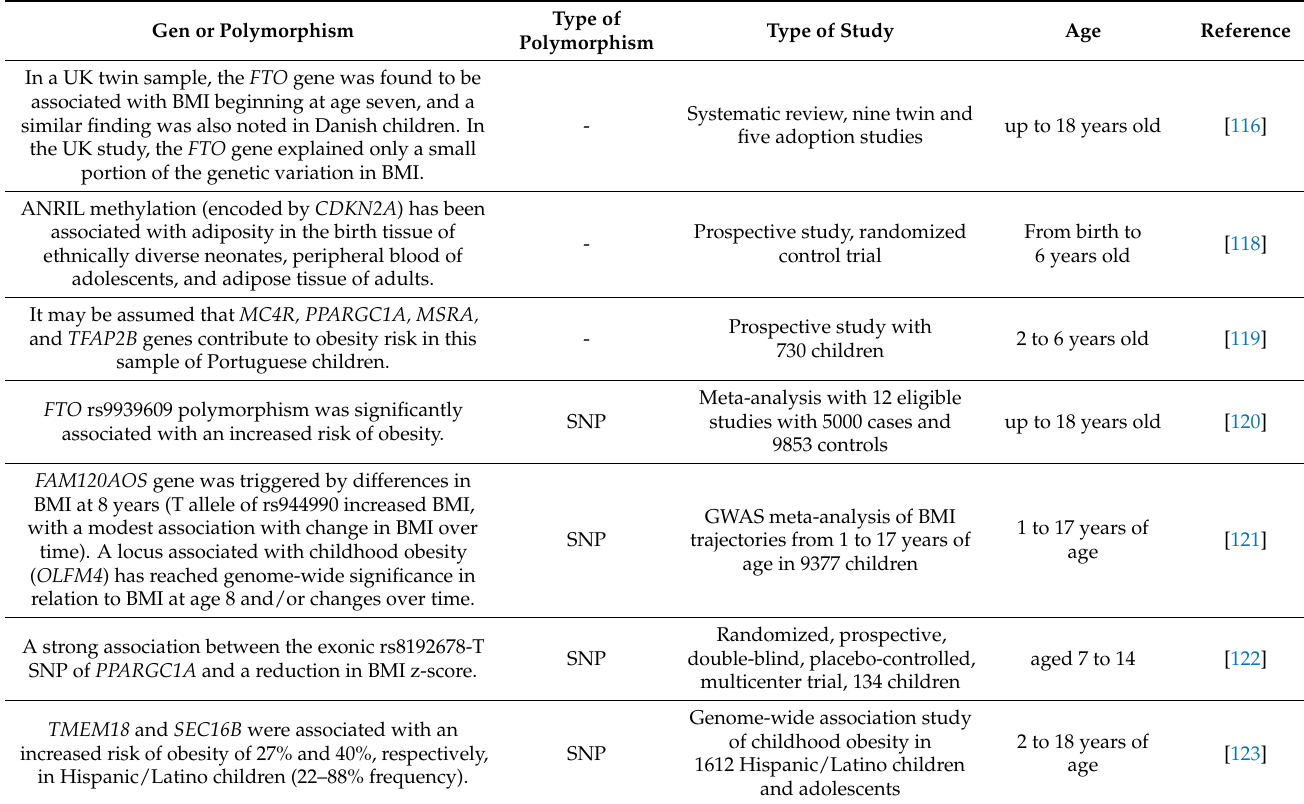
Table 1. Genetics and the onset of childhood